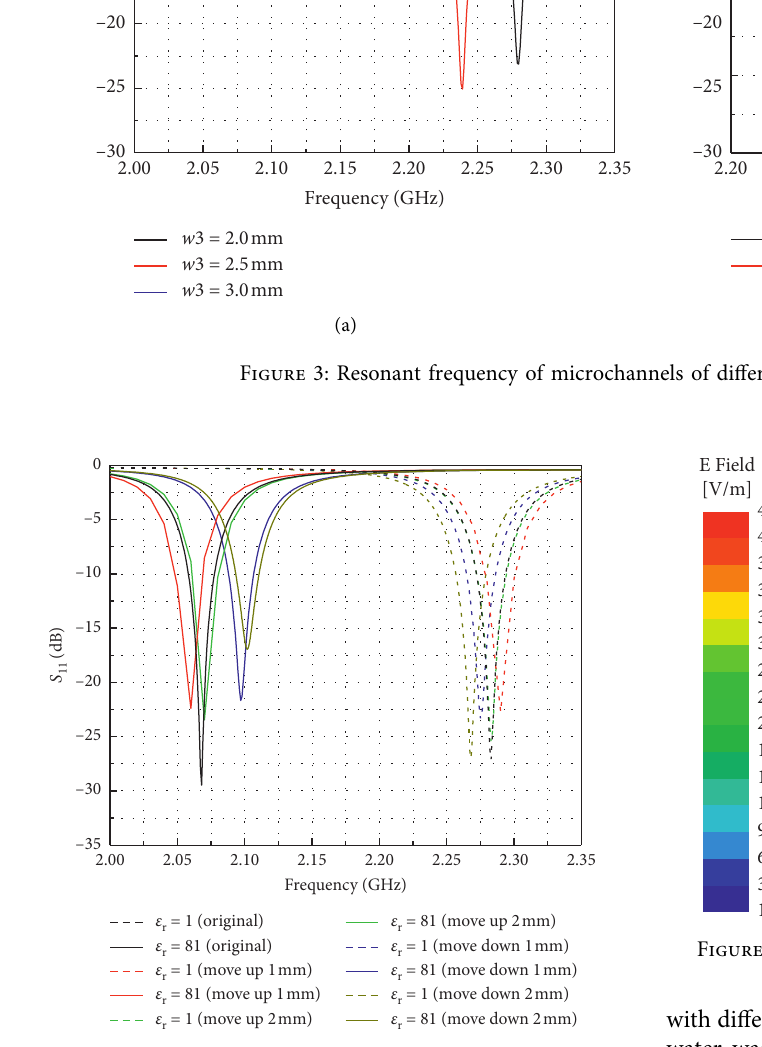
Figure 4: Resonance frequency offset caused by the change of microfluidic channel position.